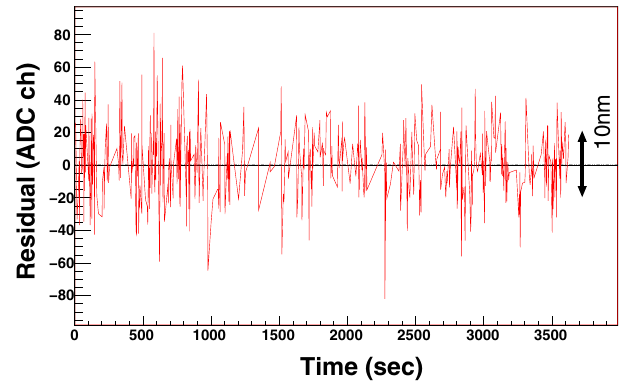
FIG. 18. (Color) Trend of the residual in a long